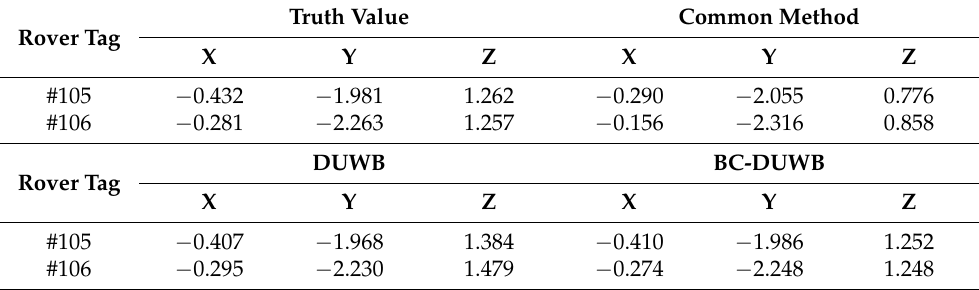
Figure 9. ( a ) The positioning results of rover #105 with different methods (Test 1); ( b ) The positioning results of rover #106 with different methods (Test 1). Table 4. The mean and truth values using different positioning methods of Test 1 (m).